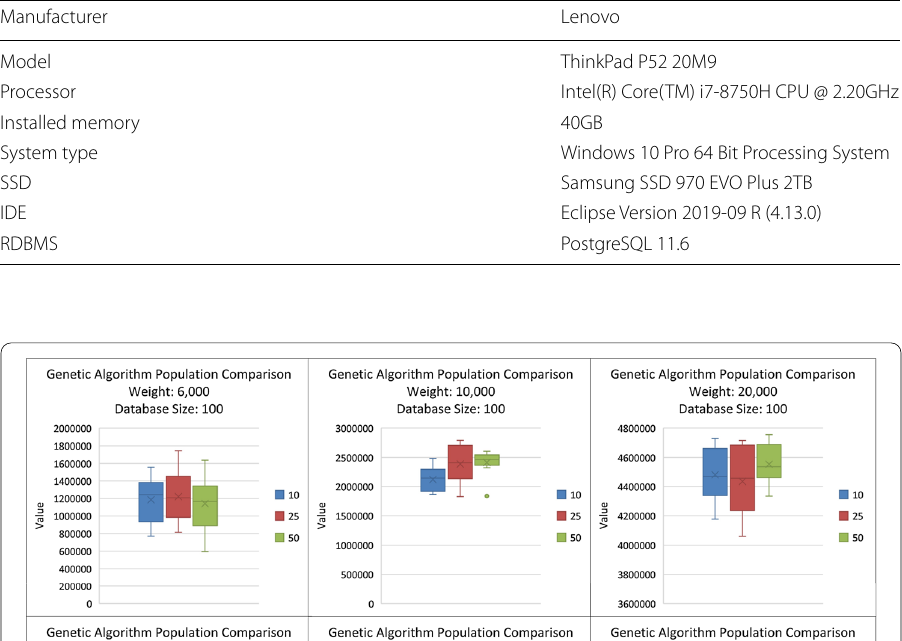
Table 4 Testing equipment and software Manufacturer